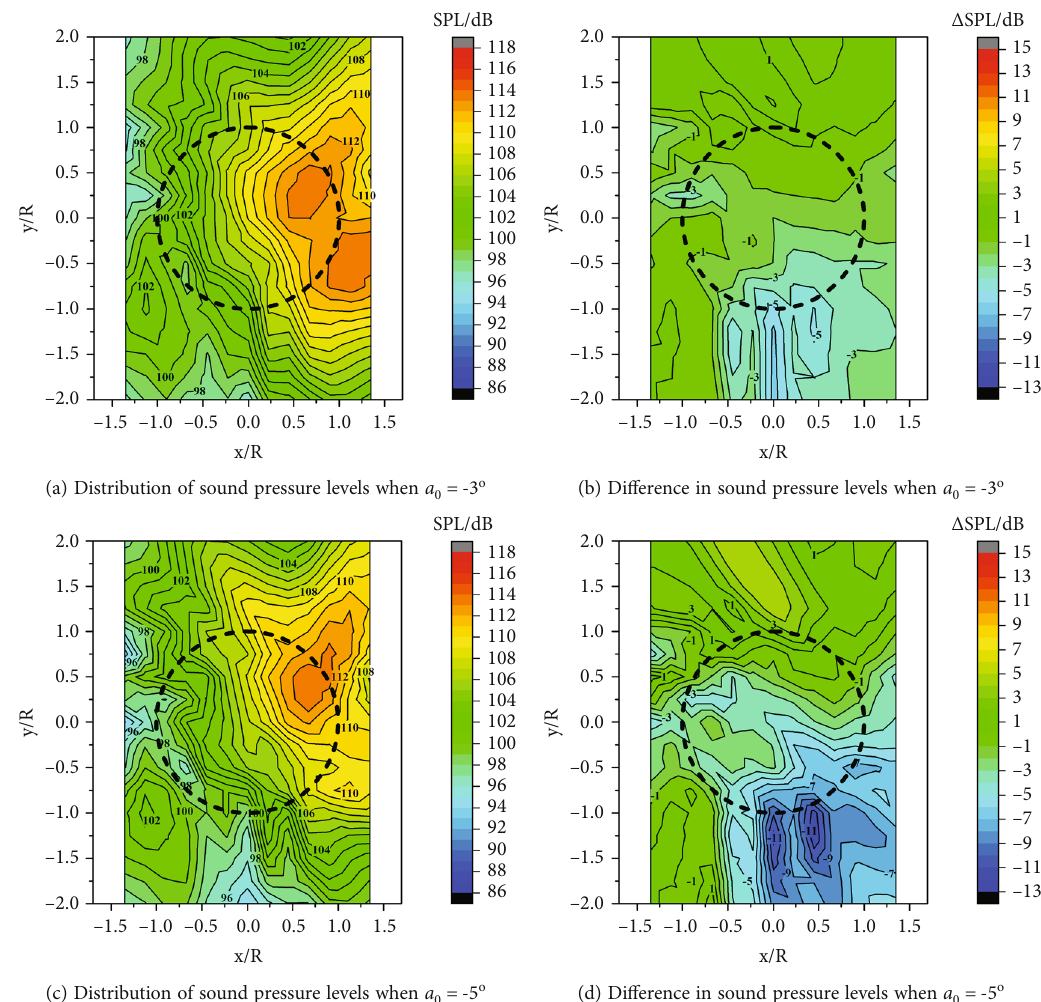
Figure 12: Distribution of SPL below the ECR under Scheme B and their di ff erence from the SPL in the reference